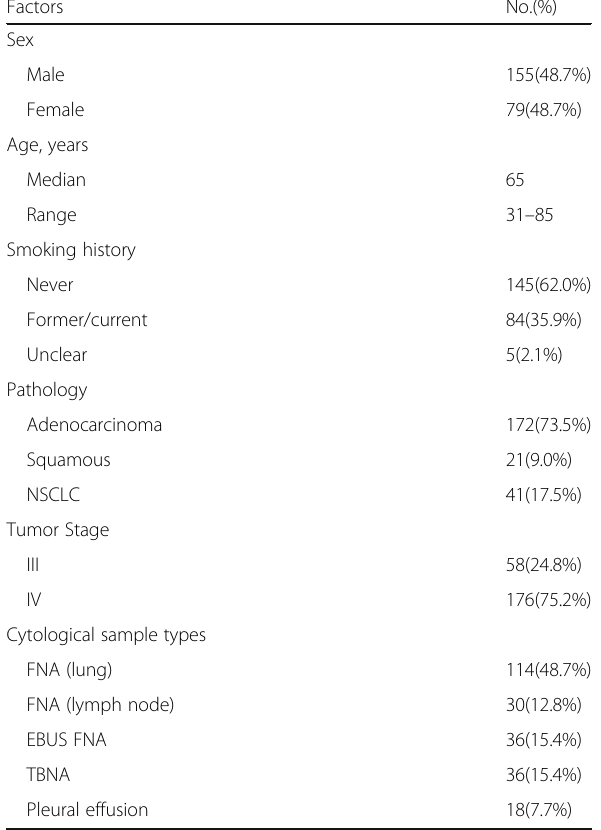
Table 1 Clinical characteristics ( n = 234) Table 2 Comparison of EGFR mutation status using ARMS